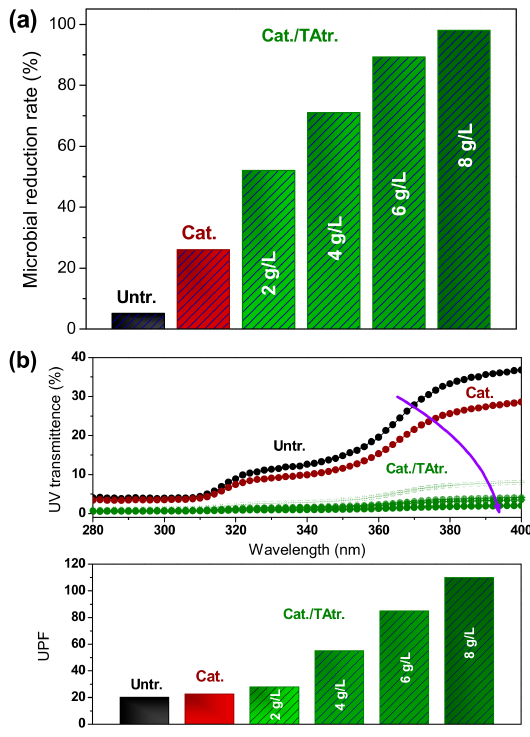
Figure 9. ( a ) Antibacterial and ( b ) UV-protective properties of Untr., Cat., and Cat./TAtr.